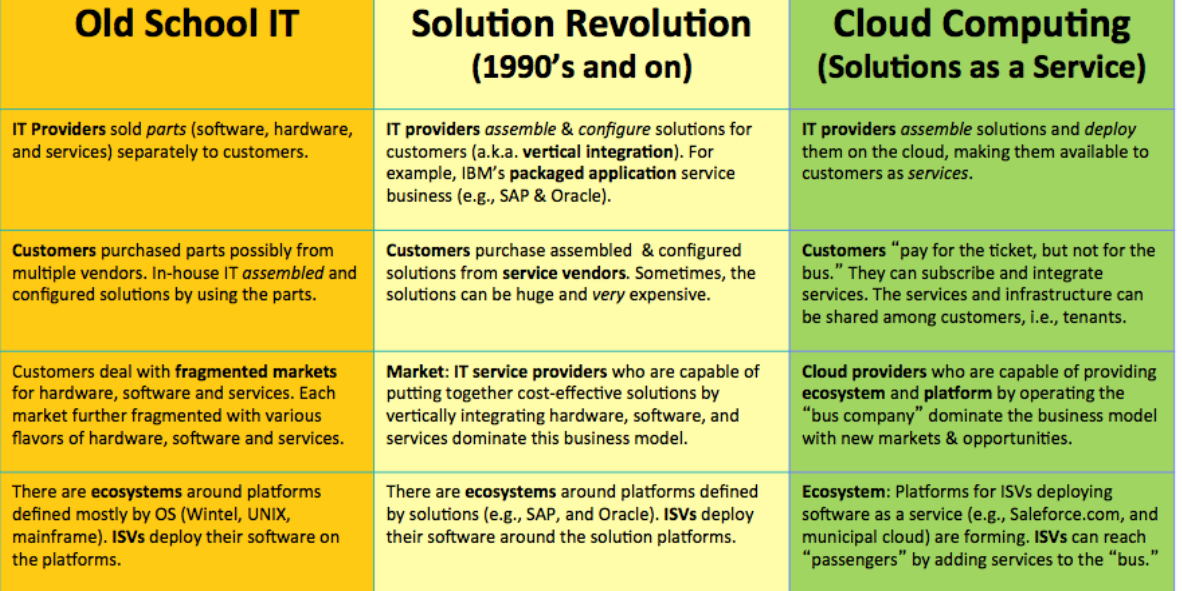
Fig. 2. Evolution of IT Delivery leading to Cloud